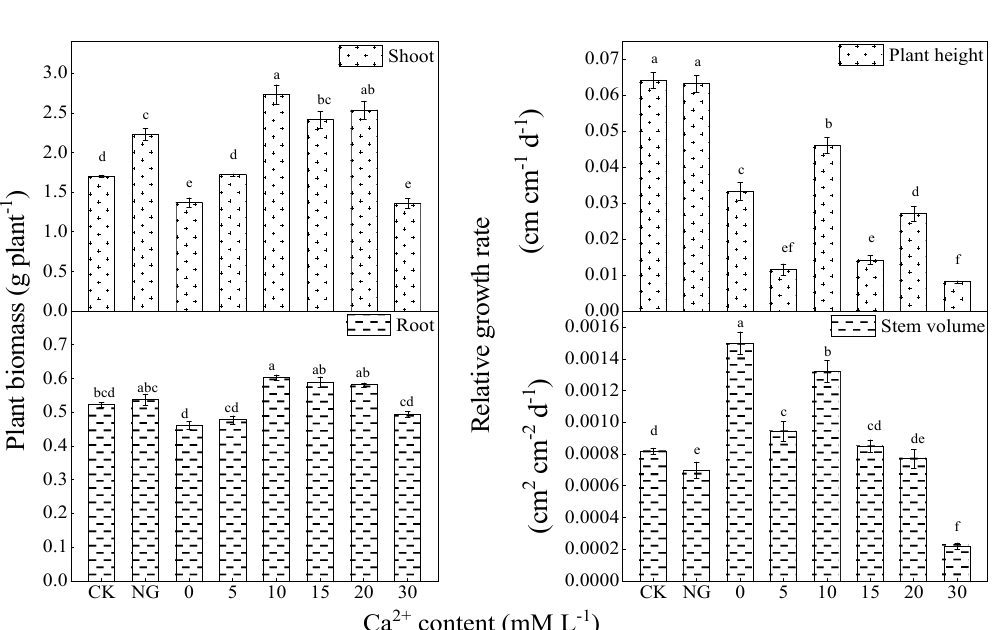
Figure 1. Cucumber seedling shoot biomass, root biomass, relative growth rate of plant height (PH), and stem volume (SV) under grafting and Ca 2+ treatments under salt stress. Bars represent standard errors. Different letters indicate a significant difference in the same parameter between treatments at p < 0.05.